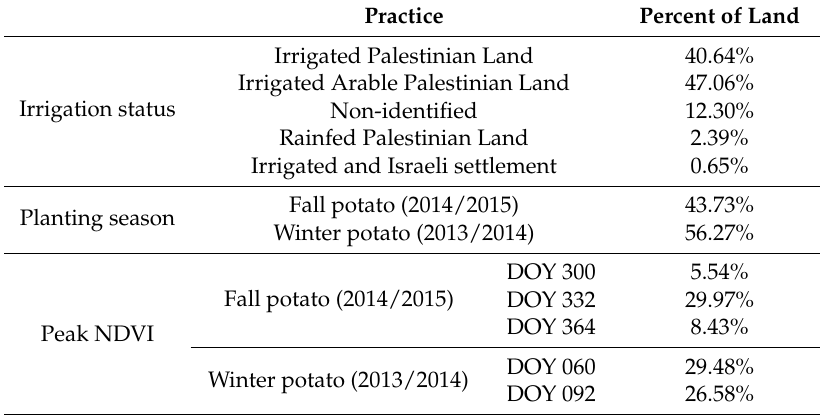
Table 2. Fraction of irrigated and non-irrigated area in the case